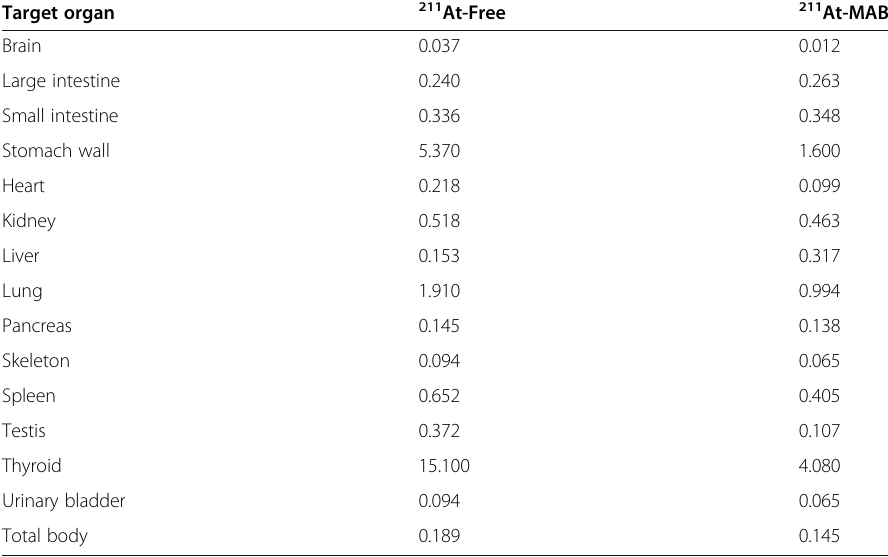
Table 4 Radiation dosimetry estimates per unit administered activity [Gy/MBq] for free 211 At and 211 At-MABG for 25 g mouse phantom in OLINDA/EXM ver. 2.0, based on mouse biodistribution data Target